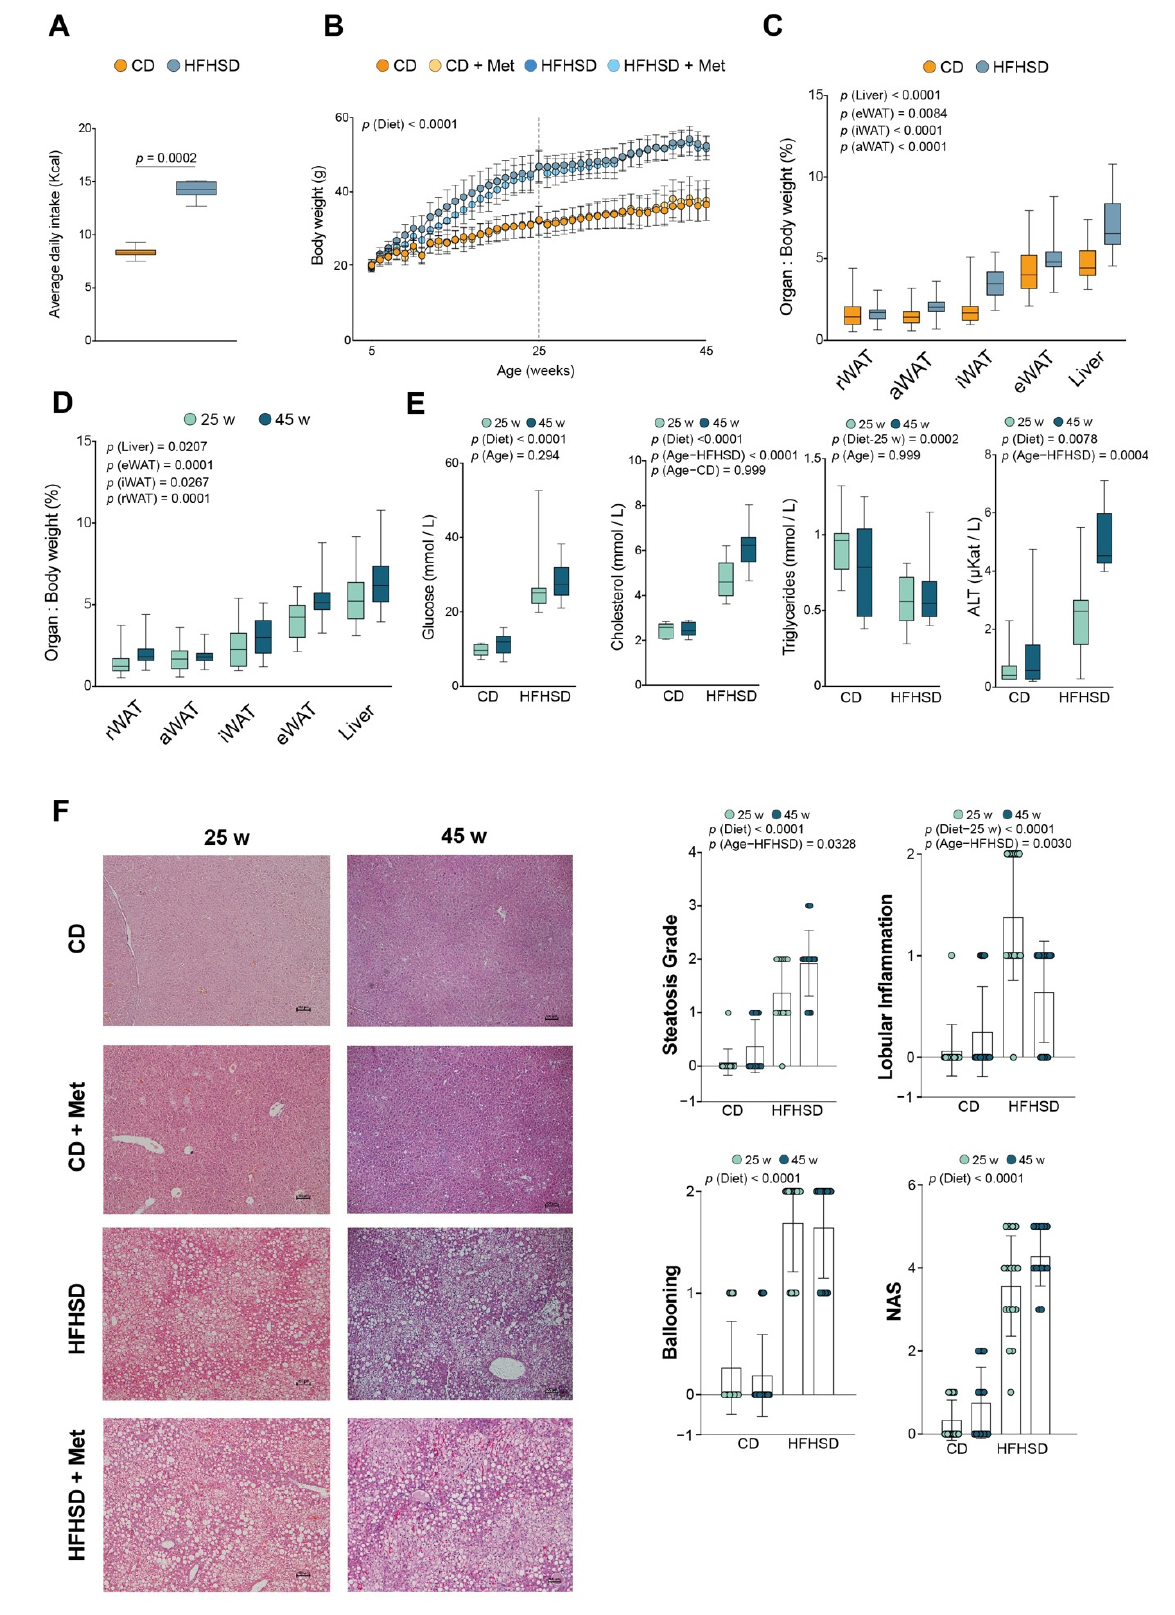
Figure 1. ( A ) Caloric intake and ( B ) body weight gain curves of CD- and HFHSD-fed mice ( n = 8/group); ( C , D ) Tissue weights in relation to dietary treatment and age; ( E ) Plasma glucose, choles- terol, triglycerides, and alanine aminotransferase activity (ALT) in animals sacrificed at 25 and 45 weeks of age ( n = 8/group); ( F ) Representative histological images of liver sections of mice ( n =